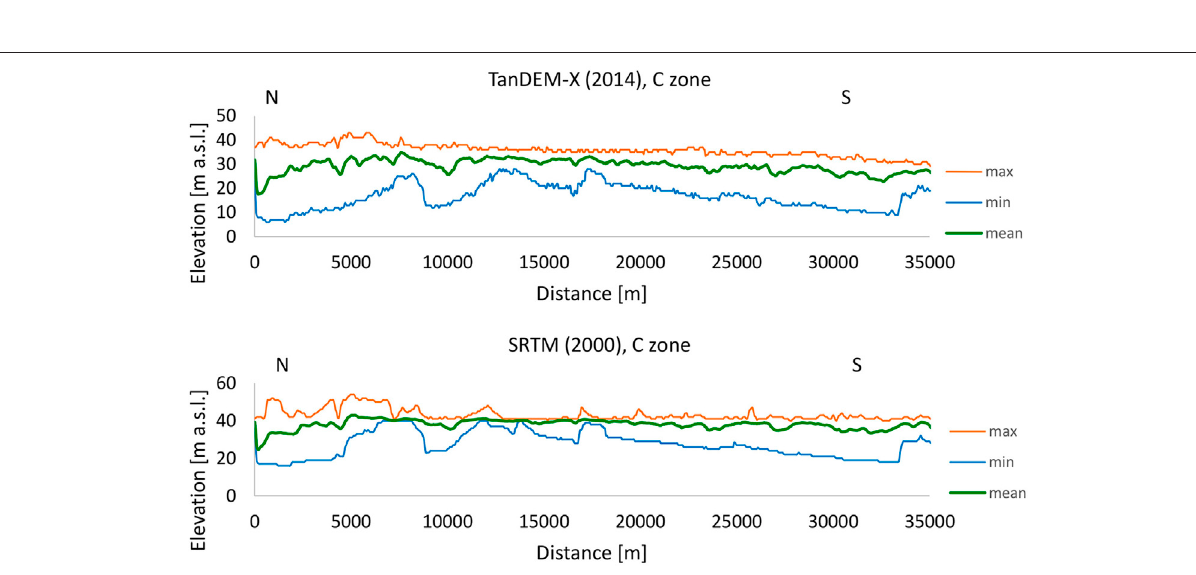
Frontiers in Earth Science |